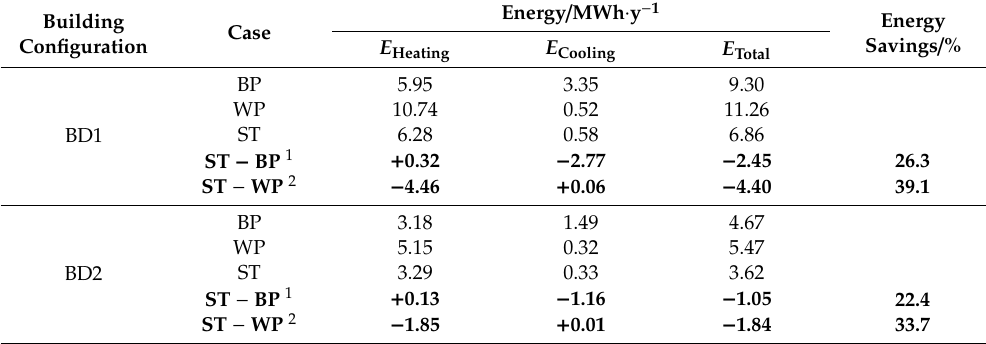
Table 6. Final energy demand for heating ( E Heating ), and cooling ( E Cooling ), total final energy demand ( E Total ), and energy savings over the year, for a building painted with an optimized thermochromic step transition paint (ST), located in Madrid,